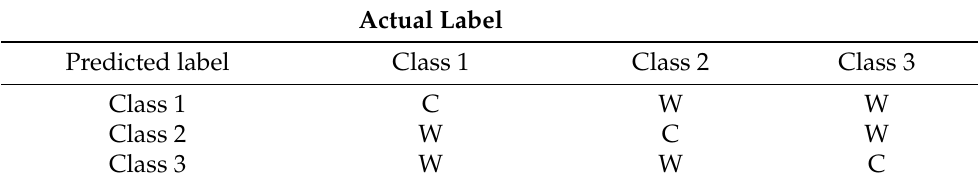
Table 3. Multi-class confusion matrix